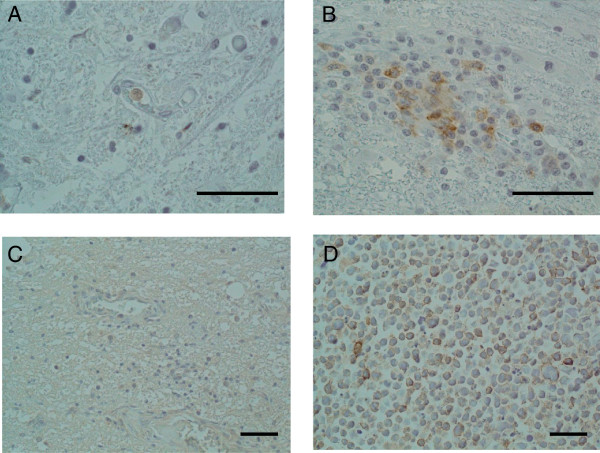
Increased expression of OX40 in vivo in rapidly progressive HAM/TSP patients.A. The plasma levels of soluble OX40 (sOX40) measured by ELISA. The plasma levels of sOX40 in typical HAM/TSP patients (chronic HAM: n=20), asymptomatic carriers (ACs: n=9) and normal uninfected healthy controls (NCs: n=13). B. No correlation between the plasma levels of sOX40 and HTLV-1 proviral load (tax copies/10,000PBMCs) from 29 HTLV-1 infected individuals (20 chronic HAM/TSP patients and 9 ACs). Data were analyzed by Spearman rank correlation. C. The cerebrospinal fluid (CSF) levels of sOX40 in rapidly progressive HAM/TSP patients (n=3), chronic HAM/TSP patients (n=22) and other neurological diseases including multiple sclerosis (MS) (n=12), aseptic meningitis (n=8), systemic lupus erythematosus (SLE) with neurological manifestations (n=5), chronic inflammatory demyelinating polyneuropathy (CIDP) (n=9), Guillain-Barré syndrome (GBS) (n=6), and amyotrophic lateral sclerosis (ALS) (n=9). Chronic HAM/TSP means typical cases fulfilling diagnostic criteria and rapidly progressive HAM/TSP is defined by patients’ incapacity to walk unaided within three months after symptoms’ onset. D. The levels of sOX40 in the CSF from HTLV-1 infected other inflammatory neurological diseases (HTLV-1+ OINDs), i.e. any inflammatory neurological disorders except for HAM/TSP which occurred in HTLV-1 infected individuals, was not significantly different from that of chronic HAM/TSP, whereas the levels of sOX40 from HTLV-1+ OINDs was significantly increased than that of non-infected OINDs (HTLV-1- OINDs). HTLV-1+ OINDs: 1 multiple sclerosis (MS), 1 SLE with neurological manifestations, 4 aseptic meningitis. HTLV-1- OINDs: 9 MS, 5 SLE with neurological manifestations, 7 CIDP, 5 GBS.